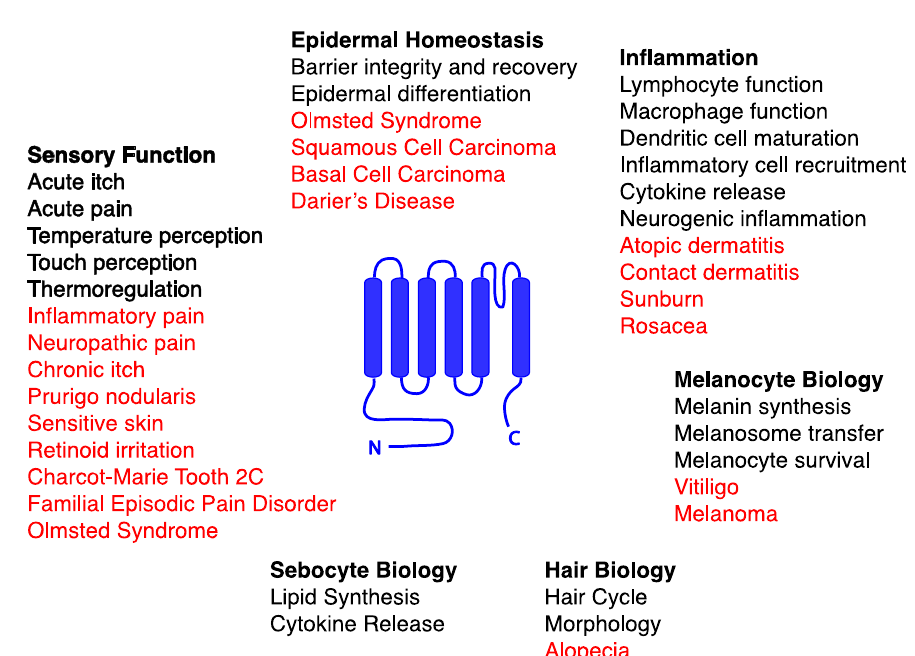
Figure 1. Summary of physiological (black) and pathophysiological (red) processes to which Transient Receptor Potential (TRP) channels contribute in various skin cell types. Topological diagram of a TRP channel subunit is shown at center, with amino (N) and carboxyl (C) termini labeled. Extracellular domain is at top.